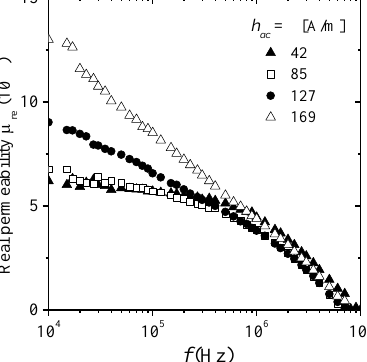
amplitude as a parameter. ac